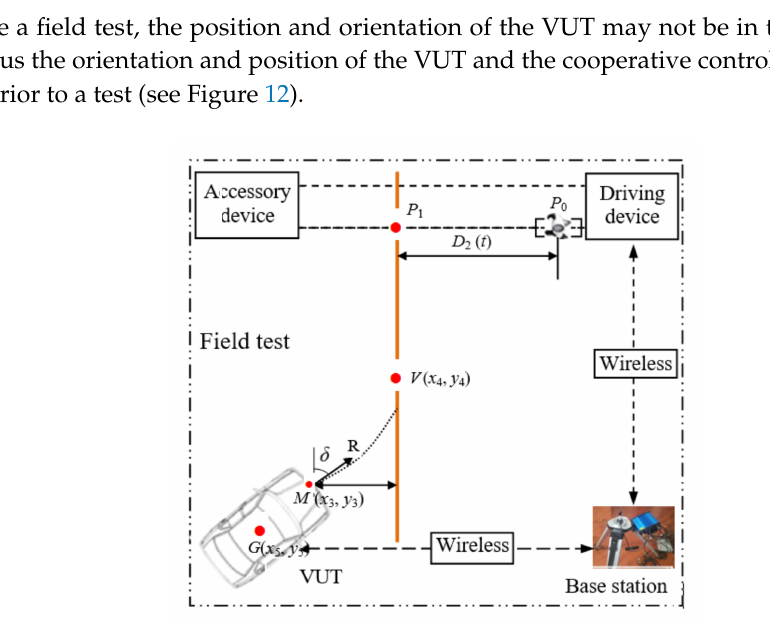
Figure 12. Adjustment of the orientation and position of the VUT for collaborative